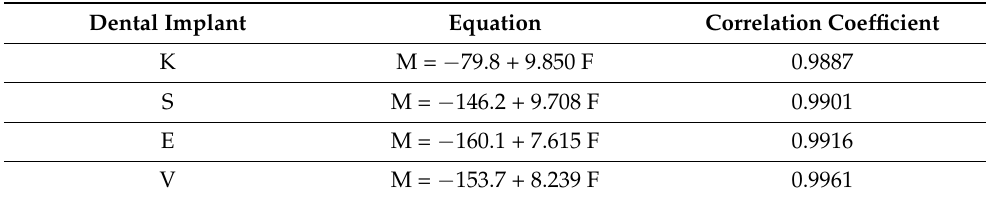
Table 1. Equations relating the micromovements (M) to the applied load (F) and their correlation